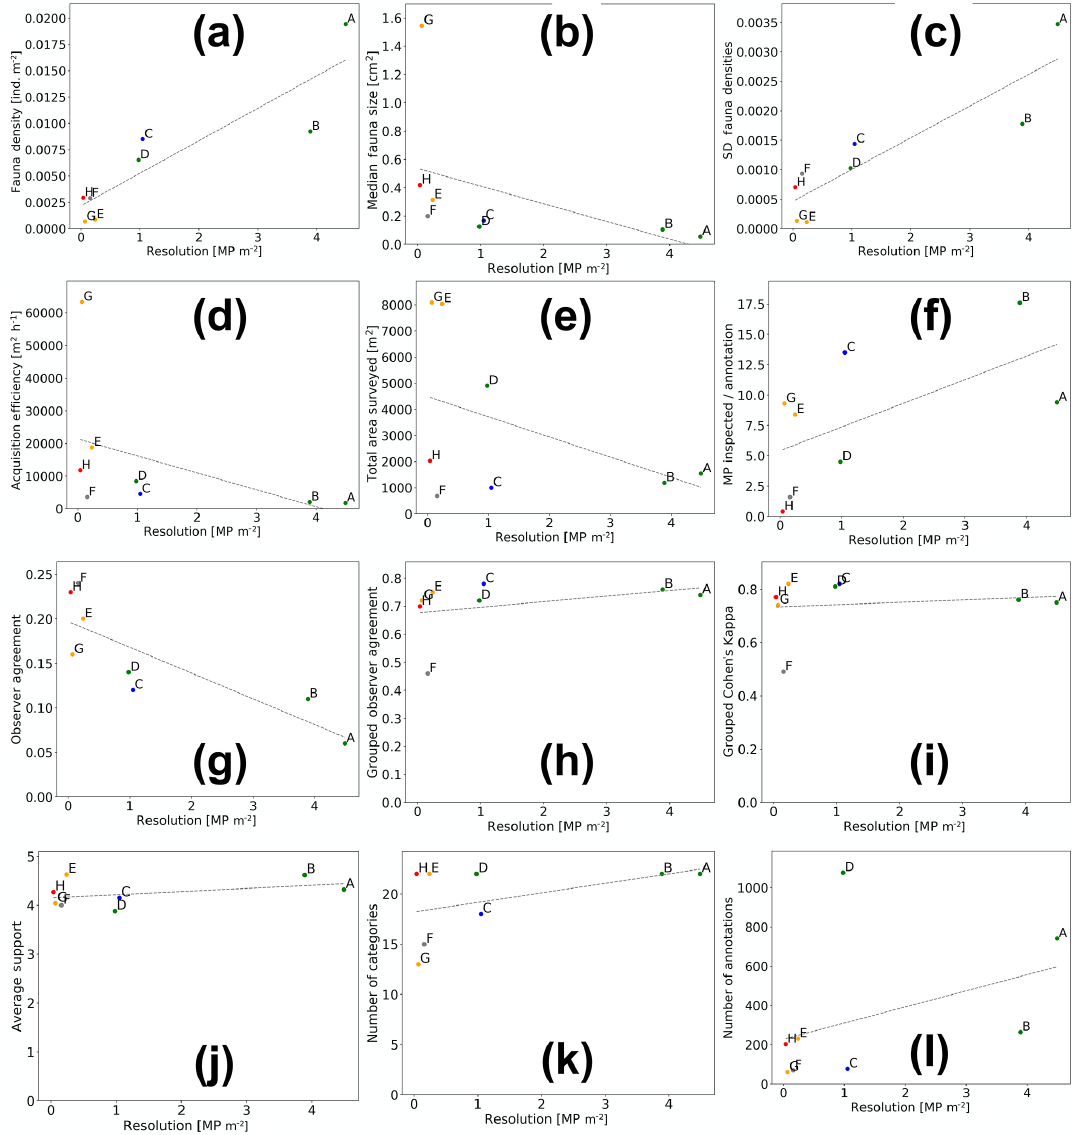
Figure 7. Aggregated results of fauna annotations for the eight datasets (dots A–H; green: AWI OFOS; blue: EXPLOS OFOS; grey: custom OFOS; orange: AUV Abyss; red: AUV Abyss mosaic). Dashed lines show linear